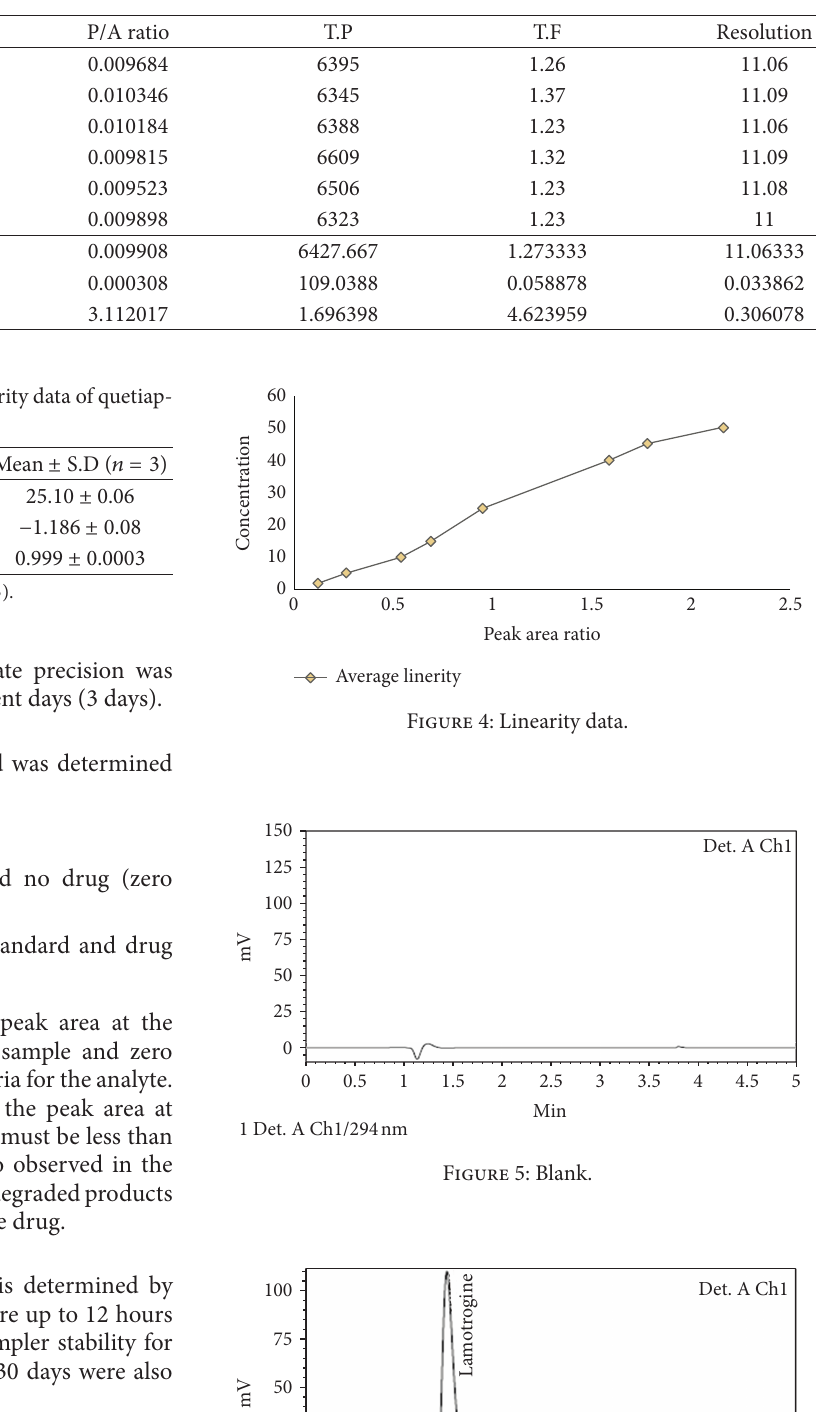
T 3: Limit of quanti�cation.